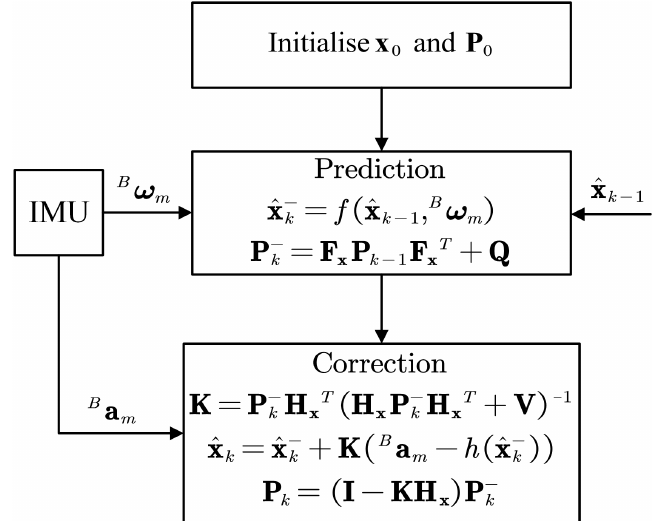
Figure 7. Procedure of the EKF to estimate the rotation